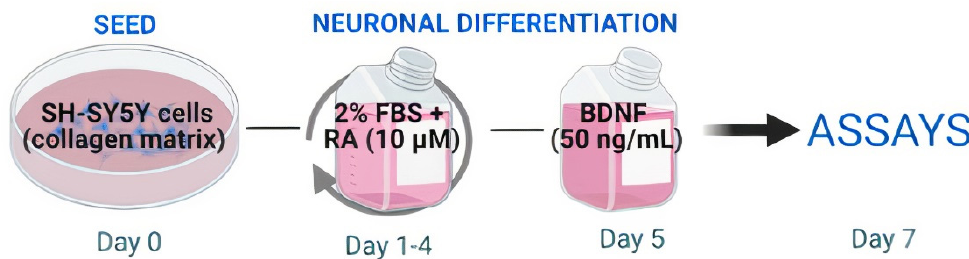
Figure 1. Schematic protocol for neuronal differentiation. On the first day (day 0) cells were plated into normal collagen coated plates. On days 1, 3, and 4, the medium was removed and the cells were incubated with a differentiation medium containing retinoic acid (RA—10 µ M). On day 5 the medium was removed and the culture was stimulated with a medium containing brain derived neurotrophic factor (BDNF—50 ng/mL). On day 7, differentiated neurons were used in the